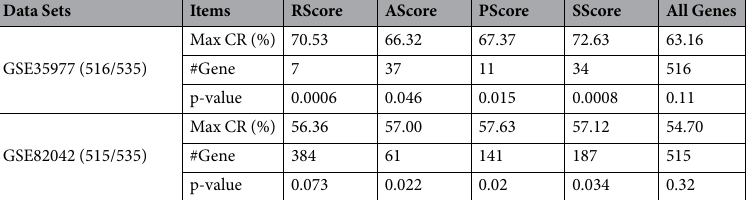
Table 2. Permutation test on top genes corresponding to highest CRs. Note: p-value in the table refers to permutation p-value, which is defined as the number of runs with equal or higher CRs, using same number of genes divided by the total number of runs.